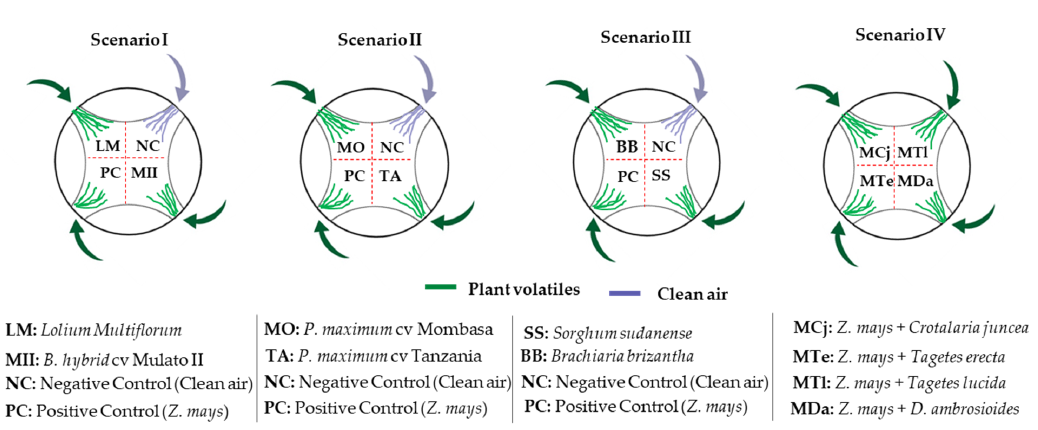
Figure 1. Scenarios considered in attraction (scenarios I, II and III) and repulsion (scenario IV) bioassays of third instar (L3) larvae of S. frugiperda in the presence of potential attractant or repellent plants in a 4-way olfactometer.